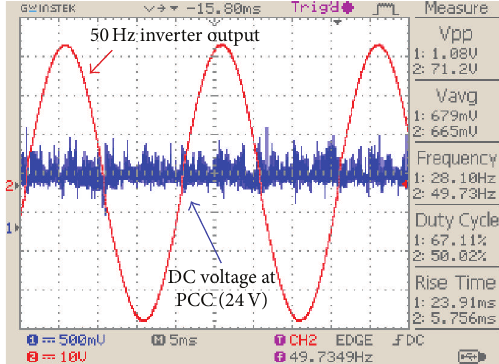
Figure 29: Experimental output of the voltage at PCC and output voltage of inverter.